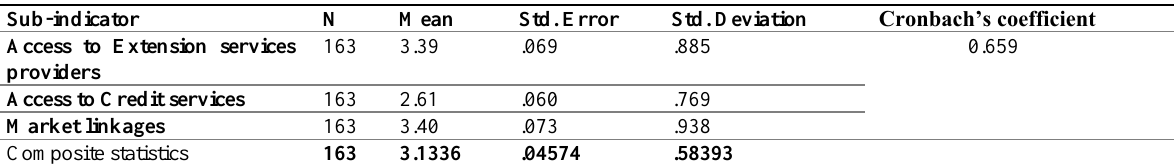
Table 4: Composite statistics for support service linkages and sustainability of donor funded livelihood project